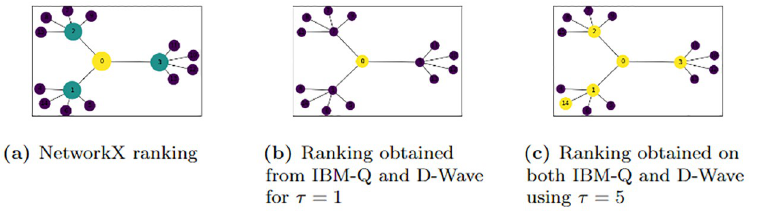
Fig 3. Most central nodes using QUBO and NetworkX’s EC. The graph G 8 showing the most central nodes using the (a) NetworkX EC algorithm, and QUBO with (b) τ = 1 and (c) τ = 5 on IBM-Q and D-Wave quantum computers for and P 1 = 5 n where n is the number of nodes of the graphs. For (a), the most central node(s) is(are) of brighter P 0 ¼ 1 ffiffi n p colors and are encircled by larger circles. In (b) and (c), the bright colored (yellow) nodes are the most central nodes whiles the dark colored (purple) nodes are the least central nodes relative to τ